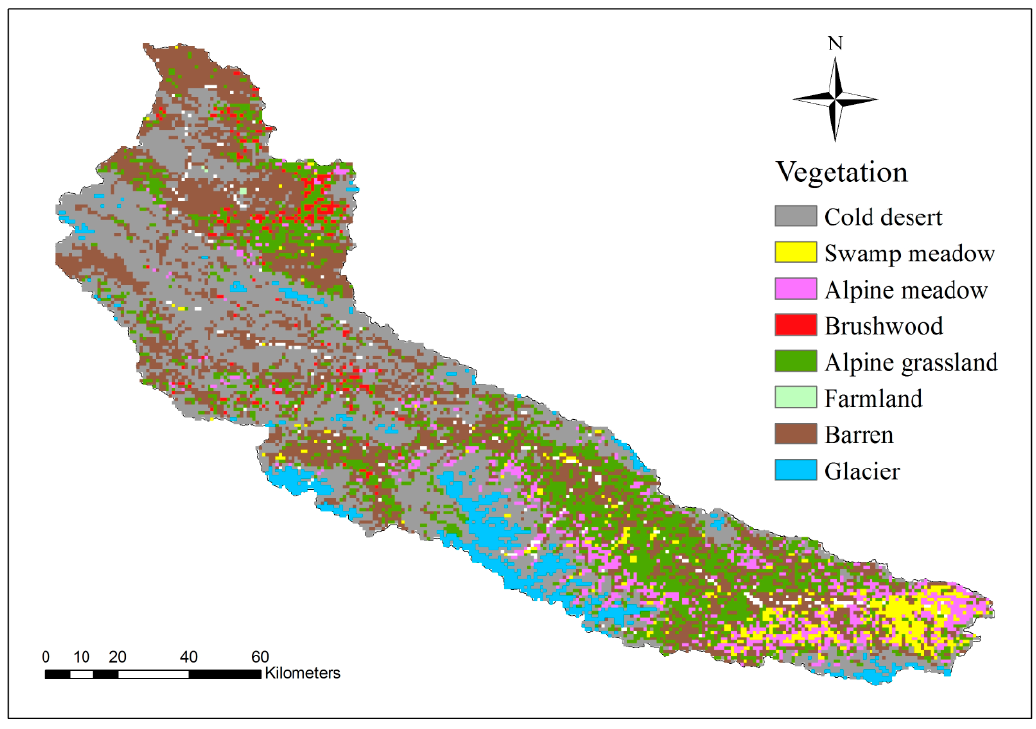
Figure 2. The spatial distribution of each land use type in the study area.